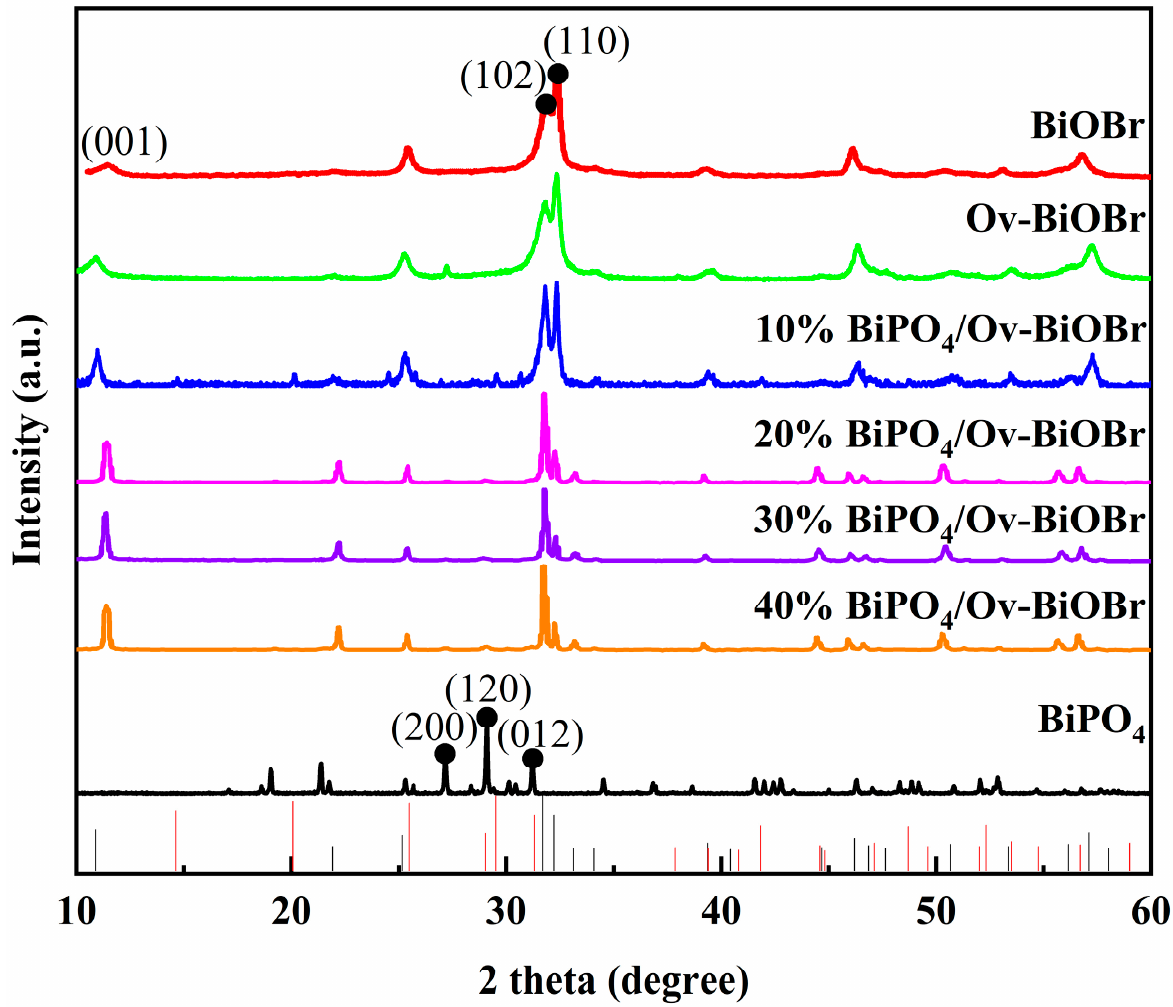
Figure 1. XRD pa tt erns of Ov-BiOBr, BiPO 4 and BiPO 4 /Ov-BiOBr composites. Figure 1. XRD patterns of Ov-BiOBr, BiPO 4 and BiPO 4 /Ov-BiOBr